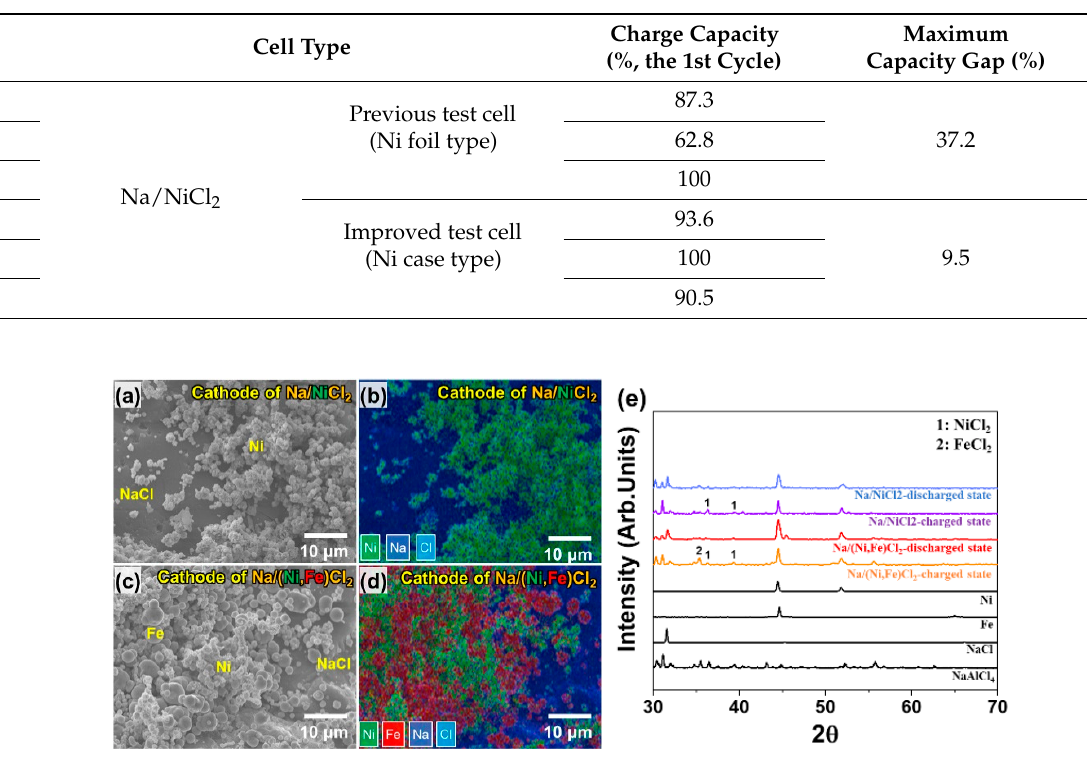
Figure 3. Cathode microstructure analysis. ( a , b ) SEM image and EDS mapping data of cathode material in Na/NiCl 2 cell (PTC-1 to 3 and ITC-1 to 3); ( c , d ) SEM image and EDS mapping data of cathode material in Na/(Ni, Fe)Cl 2 cell. (PTC-4 and ITC-4); ( e ) X-ray diffraction (XRD) spectra of raw powder and cathode materials in two test groups.